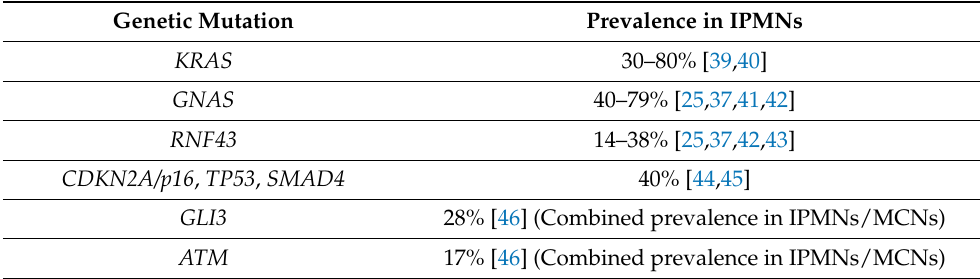
Table 2. Prevalence of somatic mutations in IPMNs that are typically found in PDACs. Genetic